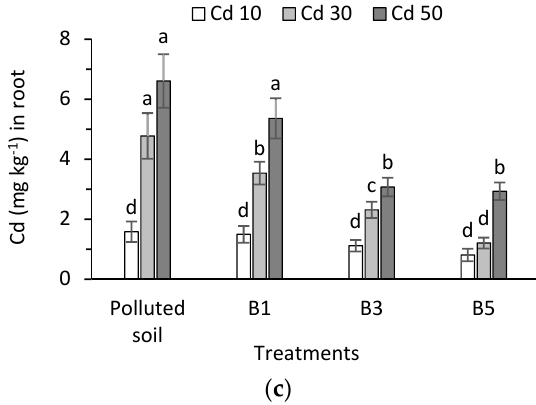
Figure 5. Effect of different levels of biochar on the concentrations of ( a ) Cd in leaves; ( b ) Cd in the stem; and ( c ) Cd in root tissue in oak seedlings at different levels of Cd contamination (means + / - one standard error). The term “Polluted soil” indicates pots with the Cd but without biochar. Different letters represent significant differences between treatments.